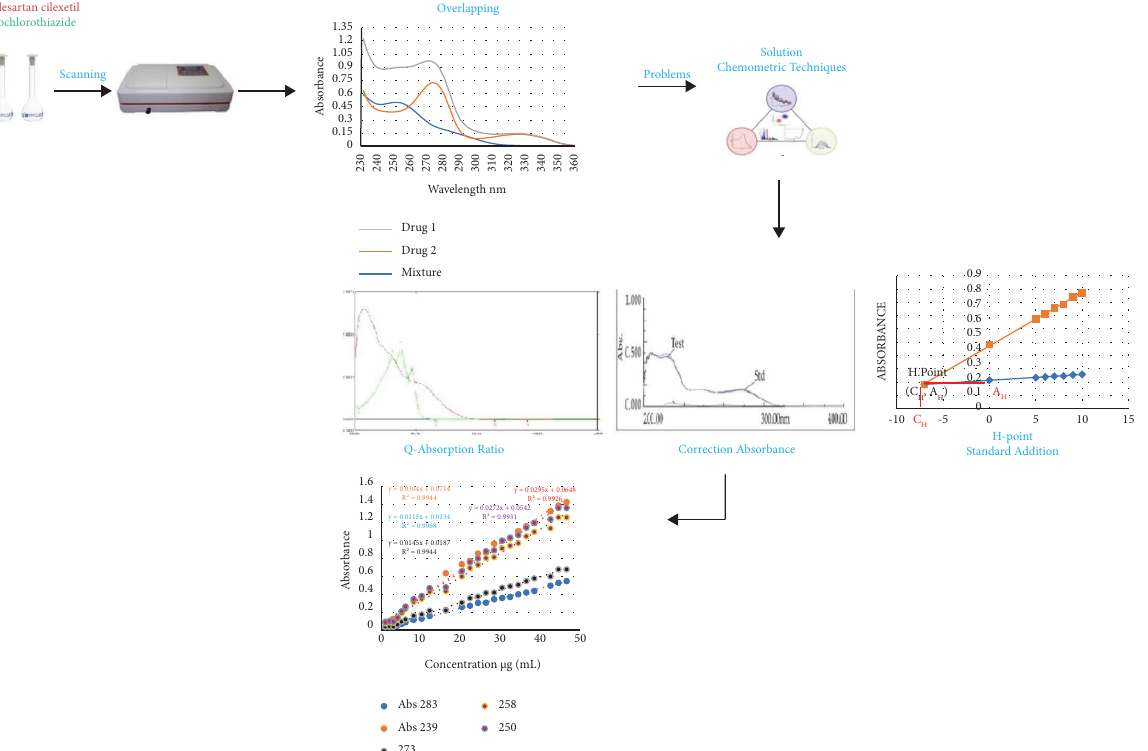
Figure 1: Schematic diagram of the proposed